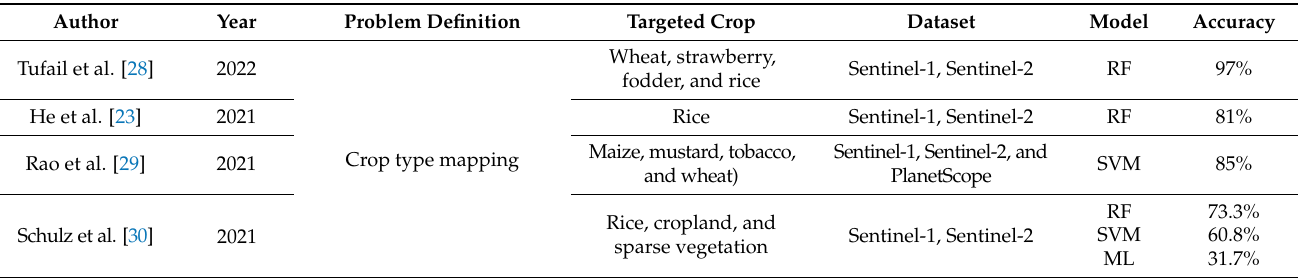
Table 1. Recent studies in crop classification techniques using Sentinel-1 and